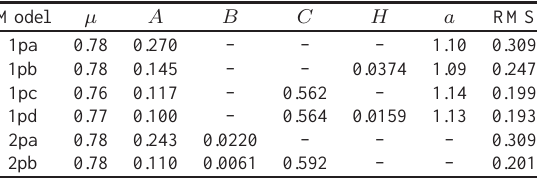
Table 3 Least squares fit results for peak overpressure data (point source